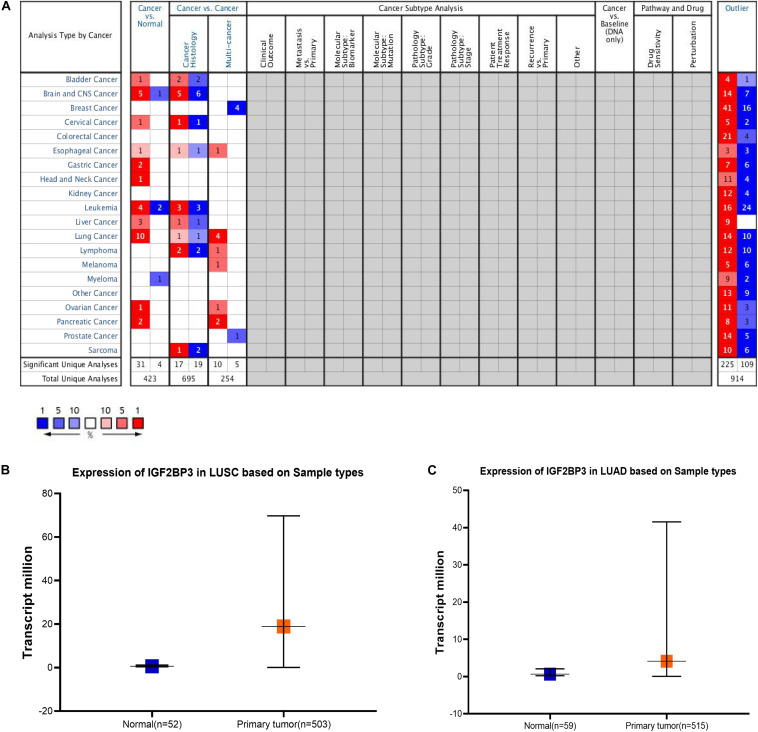
IGF2BP3 expression level was significantly increased in multiple cancer types. (A) Different expression of IGF2BP3 in multiple cancer types. The data was downloaded from Oncomine website. (B,C) Plot of the expression of IGF2BP3 in normal and LUAD and LUSC samples. The data was downloaded from TCGA website.